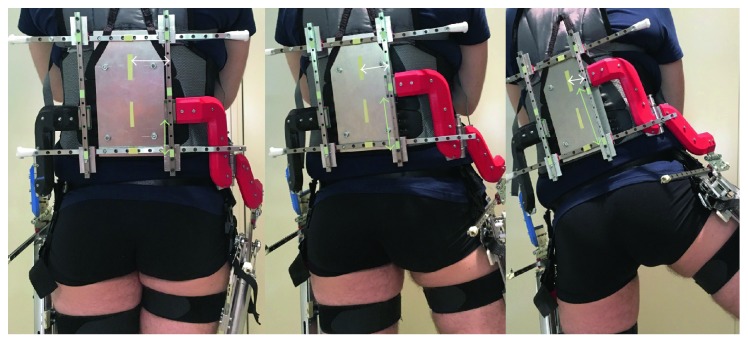
Abduction of the right leg, while wearing the novel prototype. As soon as the leg swings outwards, the vertical slider is pushed upward, as seen by the increasing green arrow. Additionally, the horizontal slider starts to move as well: it is pushed towards its center, visualised by the decreasing white arrow.